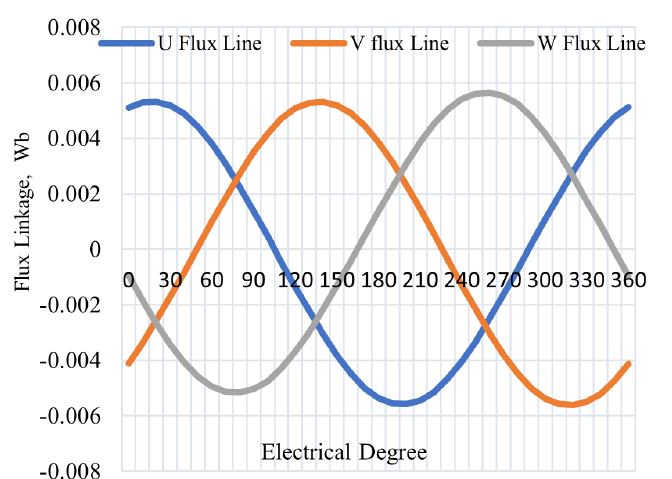
Figure 5. Three-phase flux